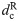
Summary of key results on different effects of triadic and axonal inhibition on relay-cell (RC) response.(A) Dependence of diameter of RC receptive-field center dcR on two key model parameters (wGIp, weight of proximal excitation of the interneuron (IN); wIRa, weight of axonal inhibition) for the case of axonal inhibition only (i.e., wIRt = 0). For this example the diameter of the ganglion-cell receptive-field center dcG is fixed to 1.8 deg, and the retinogeniculate excitation is set to wGR = 11.6 nS. (B) Transient and sustained RC responses for center-filling spots, corresponding to maximal responses in the area-response curves, for the cases of only triadic or only axonal inhibition. Dependence of maximal response on retinogeniculate excitation weight wGR is depicted. Other parameters: wIRa = 4 nS, wGIp = 0.6 nS. (C) Dependence of center-surround antagonism, quantified by the coefficient αRC (Eq 7), on wGIp, the weight of the GC excitation of INs on the proximal dendrites. Dark-blue line: No inhibition, wIRa = wIRt = 0. Red line: Axonal inhibition only, wIRt = 0, wIRa = 8 nS. Green line: Triadic inhibition only, wIRa = 0. Light-blue line: Both triadic and axonal inhibition, wIRa = 8 nS. Retinogeniculate excitation is set to wGR = 15.6 nS. In B and C simulation data points are marked with dots, and lines are added as a guide for the eye. Note that 500 trials, not the default value of 10 trials, were used to compute the depicted trial-averaged spike-count rate in panel B.